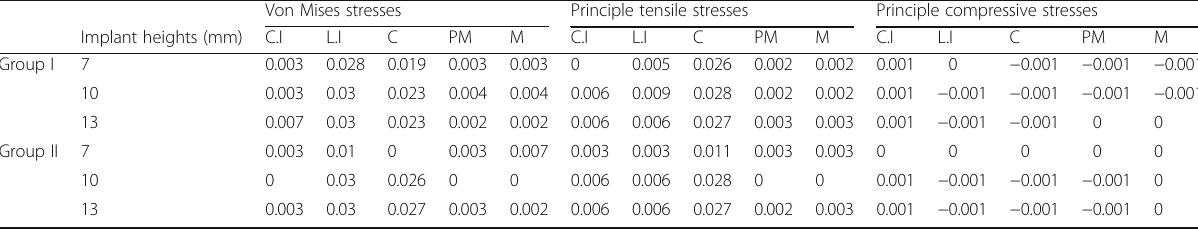
Table 6 Stresses on PDL in group I and group II non-consolidated models (MPa) Von Mises stresses Principle tensile stresses Principle compressive stresses